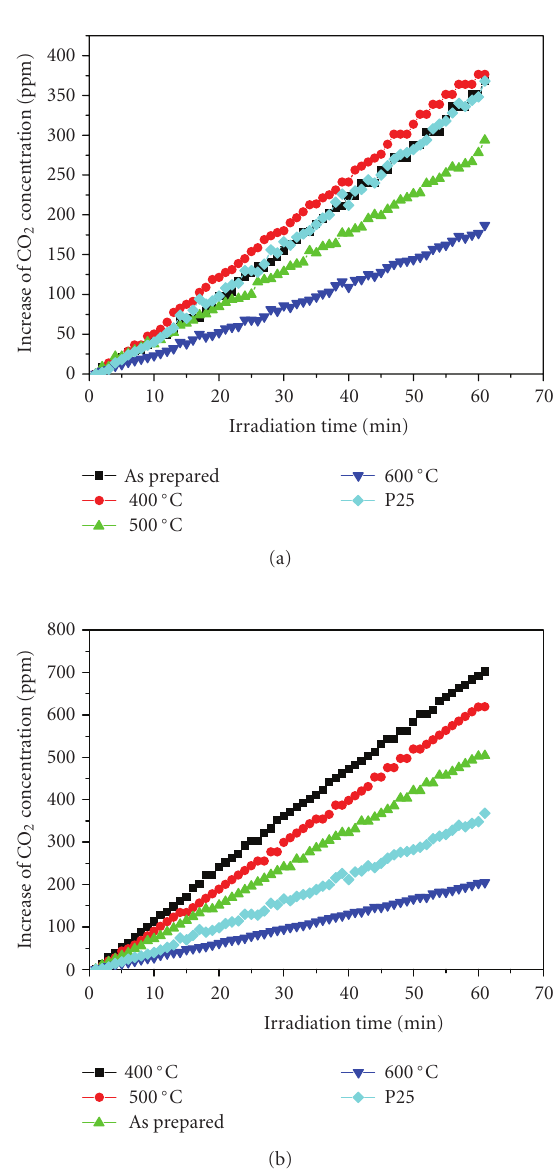
Figure 7: Increase of the CO 2 concentration due to decomposition of acetone for fluorinated TF10 (a) and TF20 (b) titania powders.